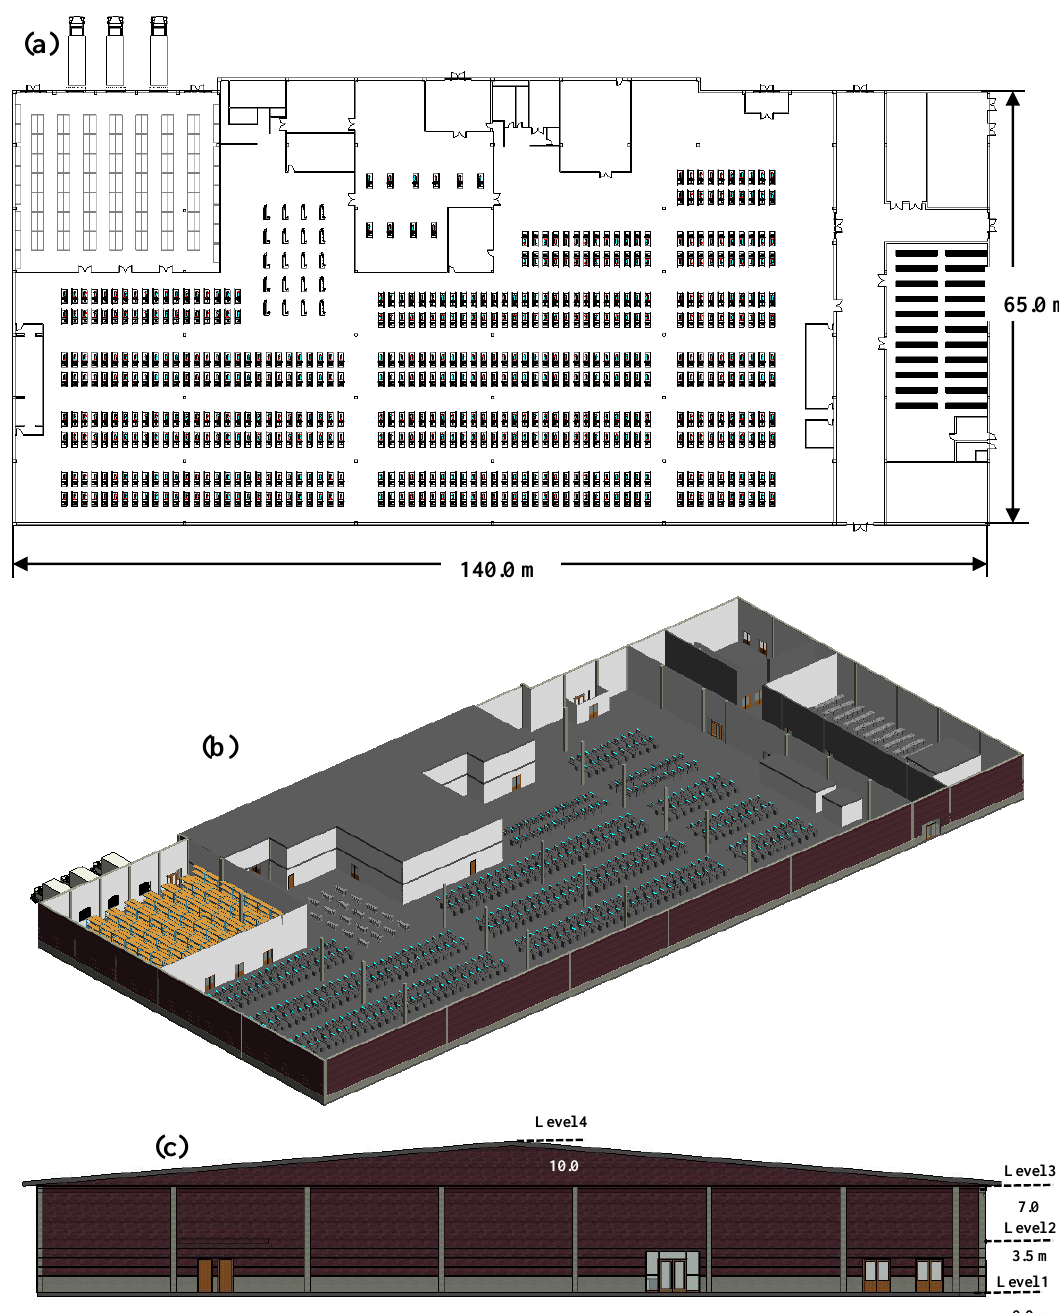
Figure A9. F9 archetype plans and sections: ( a ) Plan view; ( b ) 3-D view for the industrial building; ( c ) Side view.